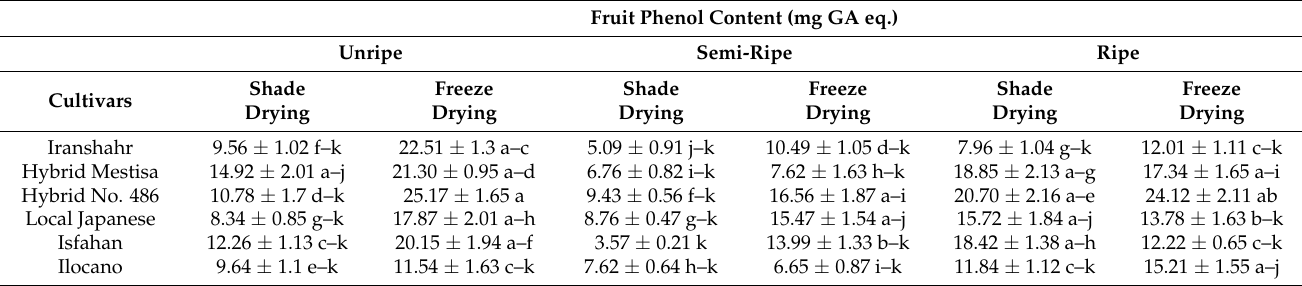
Table 5. Fruit phenol content of six cultivars of bitter melon (mg GA equivalent). Fruit Phenol Content (mg GA eq.)